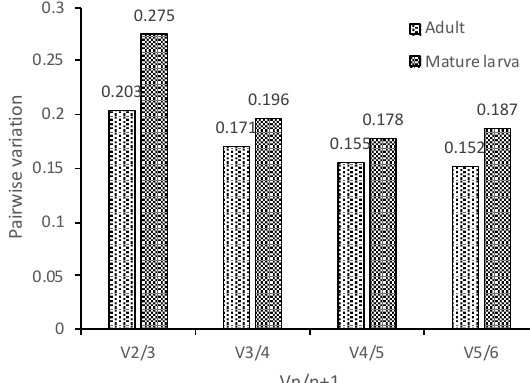
Figure 3. Pairwise variation (Vn/Vn + 1) analysis of the number of candidate reference genes in D. valens. According to the paired difference analysis of the standardized factor of the internal reference gene, the mutation value V was obtained for pairwise comparison, so as to determine the optimal number of the internal reference gene. When the Vn/n + 1 value was less than the threshold value of 0.15, the optimal number of the internal reference gene was n.